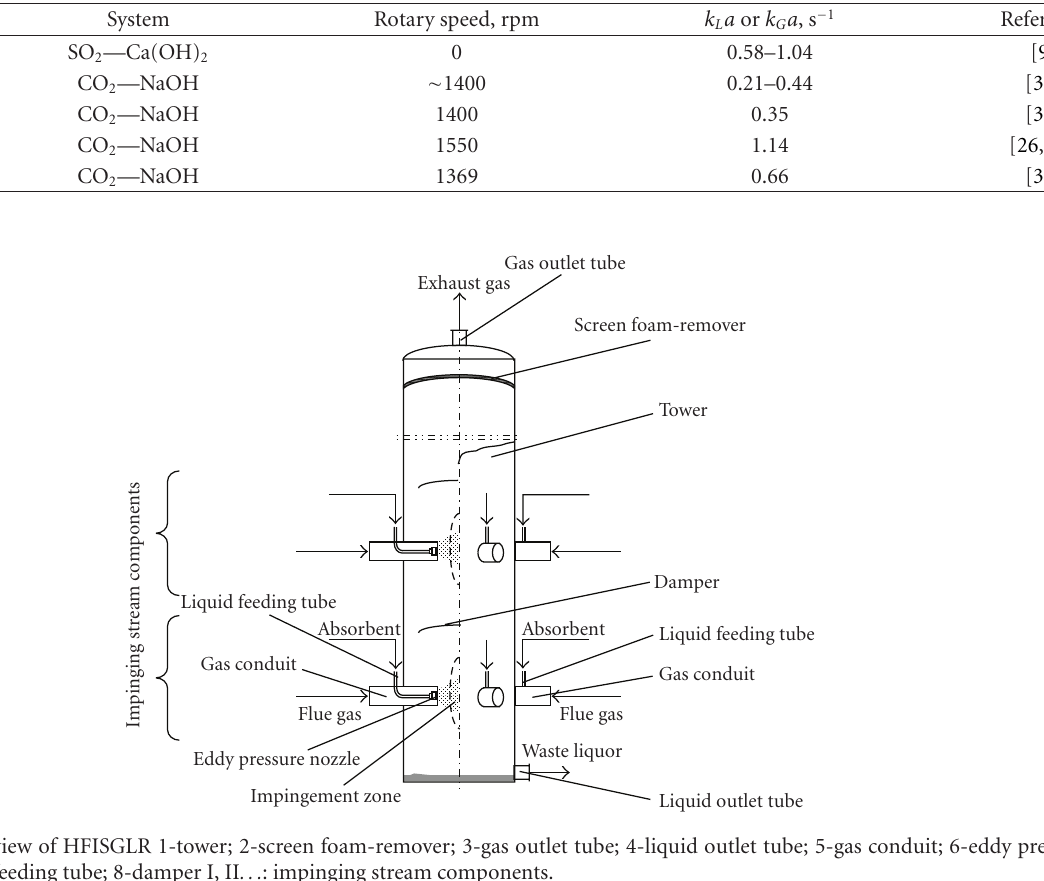
Table 2: Comparison between volumetric mass transfer coe ffi cients measured in ISGLR and RPB, respectively.